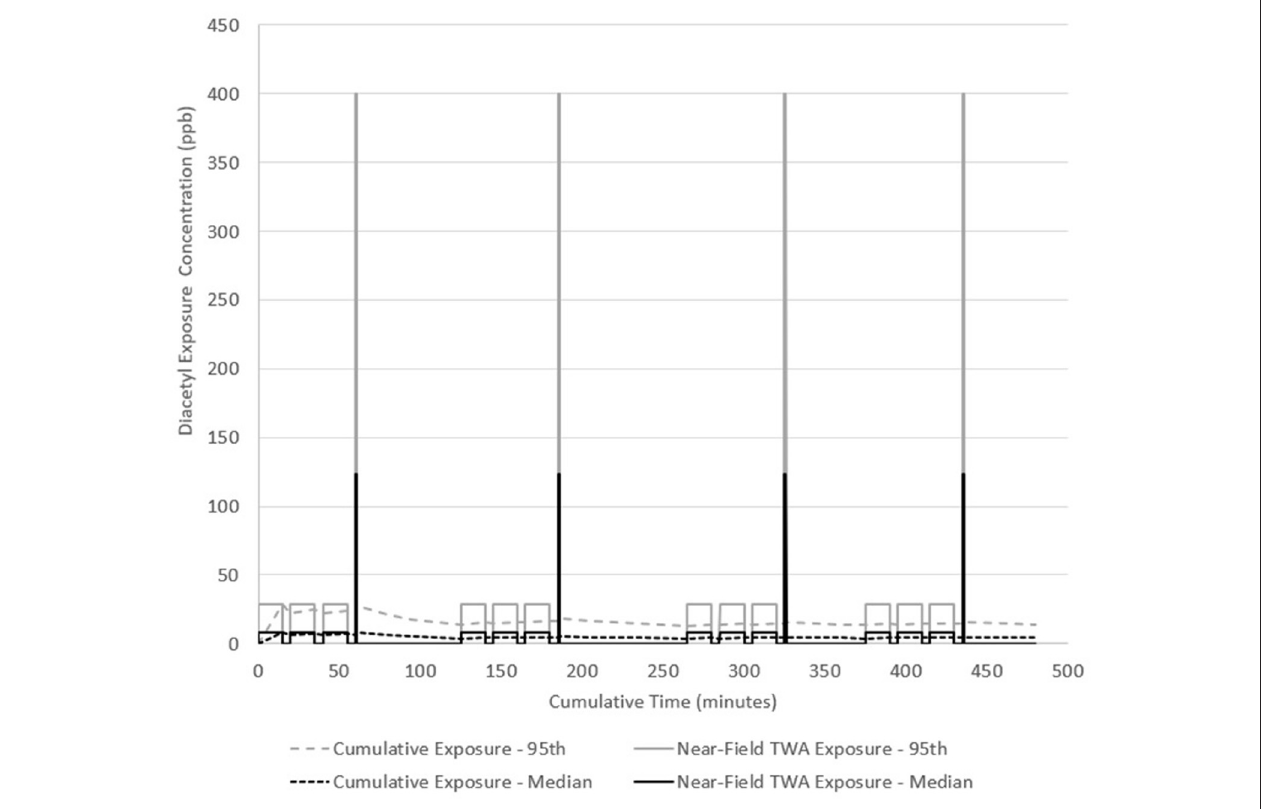
FIGURE 4 | Diacetyl cumulative exposure profile for a general production worker (Scenario B). NIOSH REL 5.0 ppb for